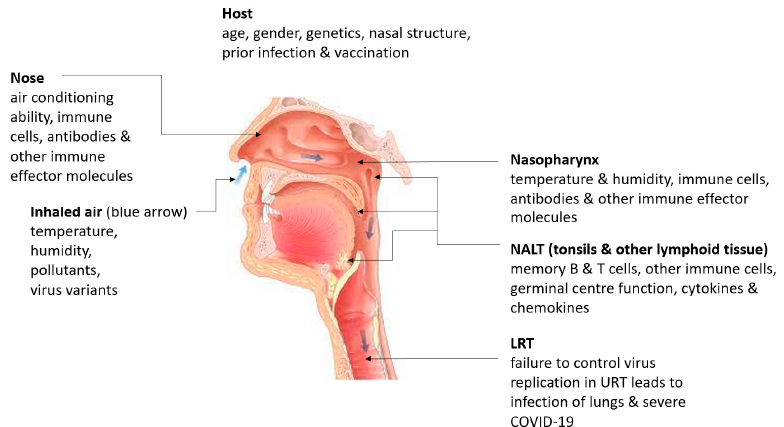
Figure 3. Overview of factors influencing immunity to SARS -CoV-2 in the upper respiratory tract. NALT—nasopharynx-associated lymphoid tissue. LRT- lower respiratory tract. Modified from Ref-